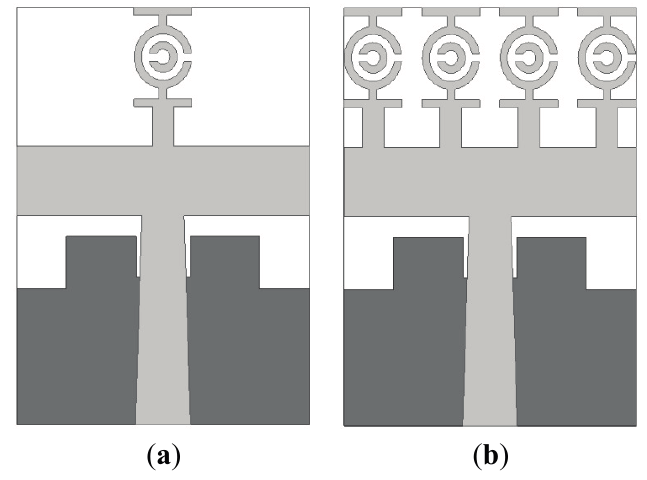
Figure 6. The MTM antenna ( a ) One element; ( b ) Four element.